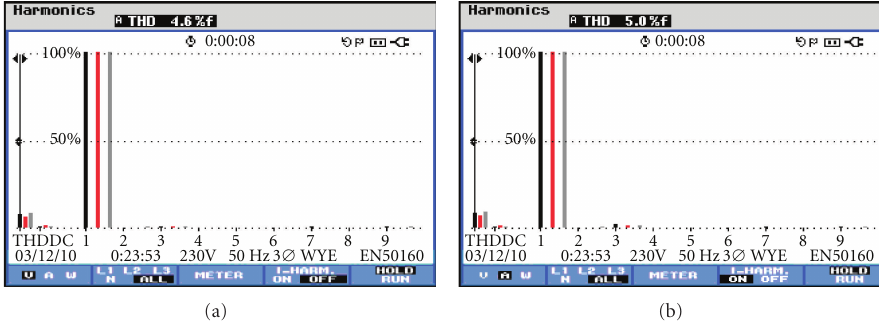
Figure 15: THD of the three-phase inverter (a) voltages and (b)